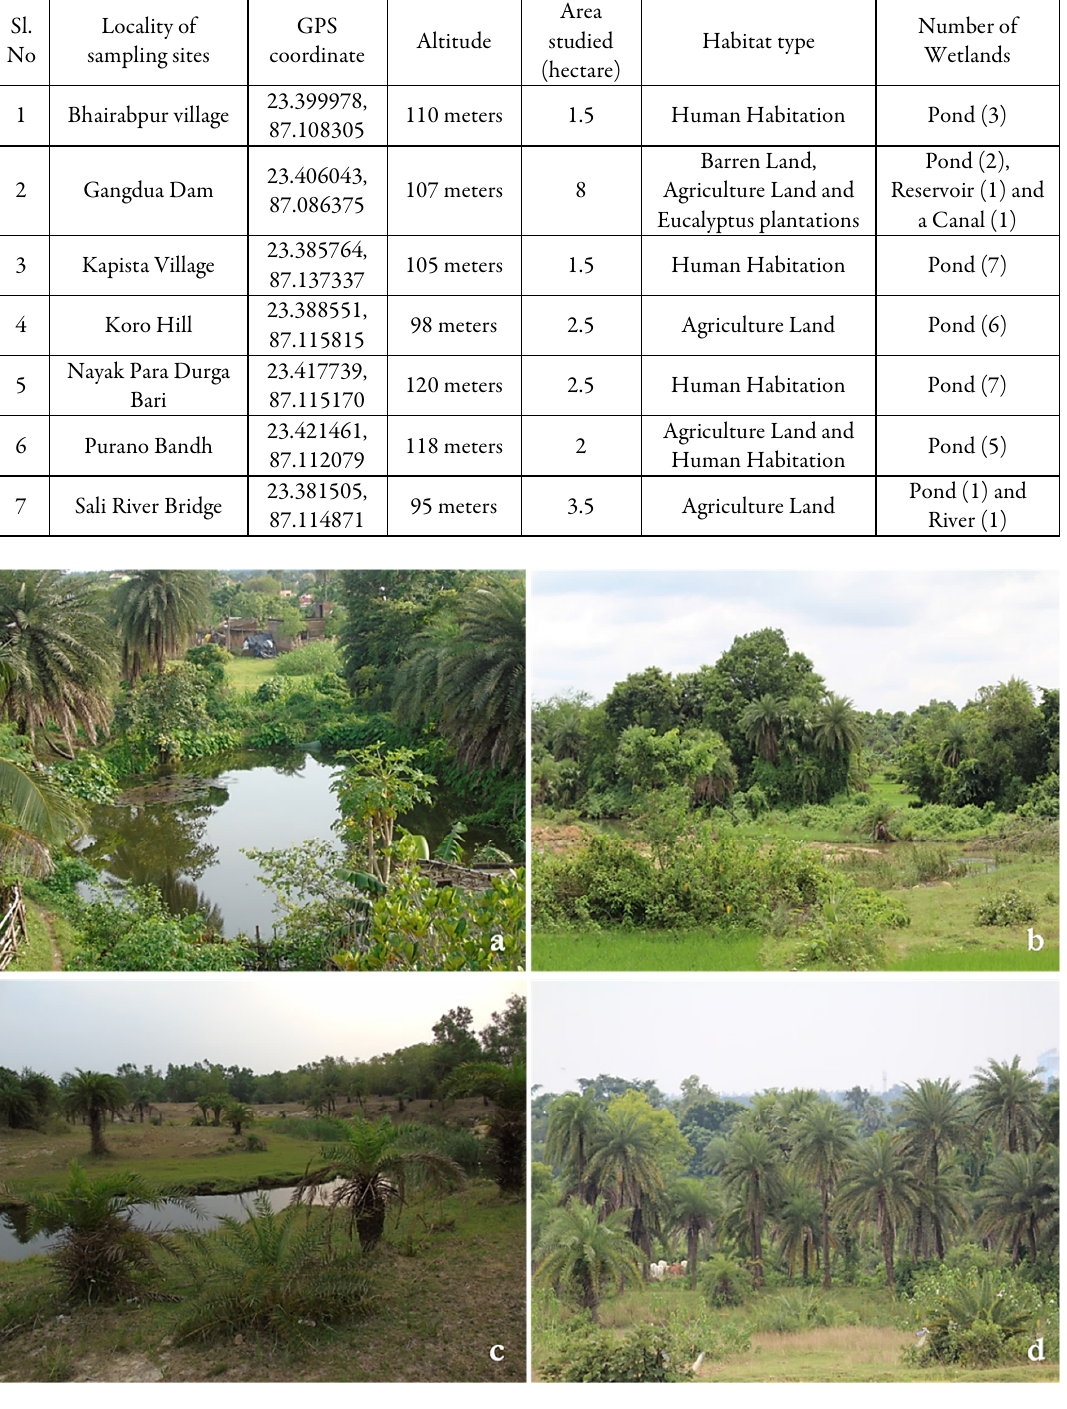
Table 1. The GPS coordinates and altitudes of the seven study sites located in the Gangajalghati block Sl.